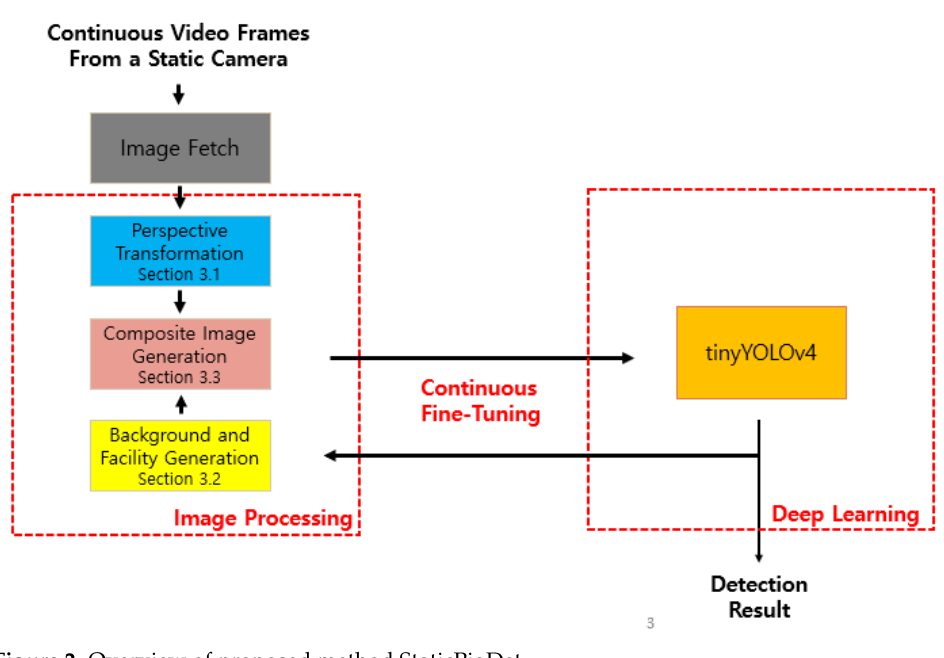
Figure 2. Overview of proposed method StaticPigDet.